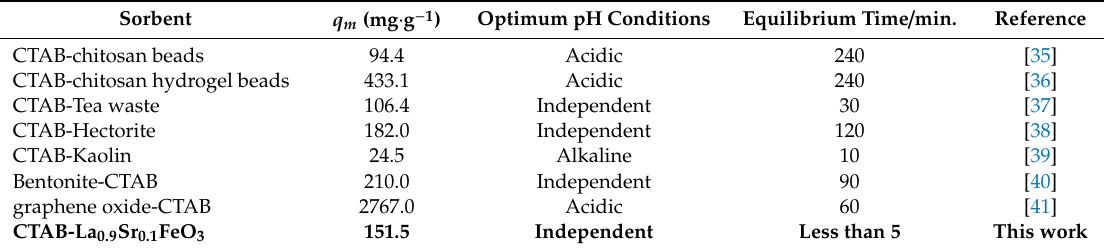
Table 1. A comparison of the sorption performance of CTAB-capped La 0.9 Sr 0.1 FeO 3 with reported CTAB-modified materials for the CR